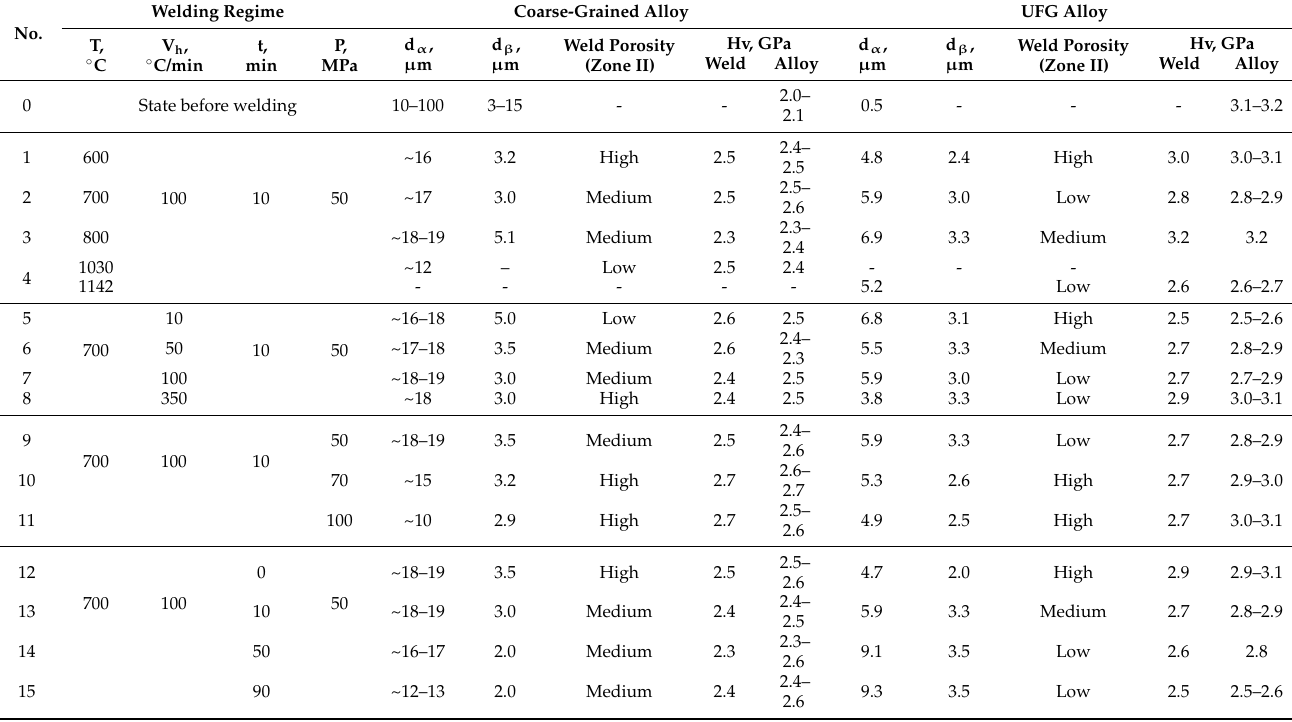
Table 2. Parameters of microstructure and microhardness of the PT-3V alloy specimens after the diffusion